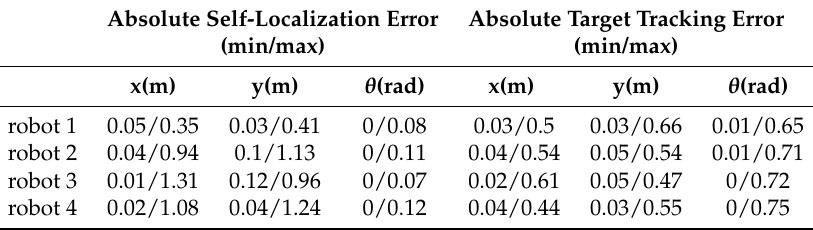
Figure 5. Self-localization errors and covariances of robots 1–4. Table 1. Self-localization and target tracking errors ( k ∈ [ 200,800 ]